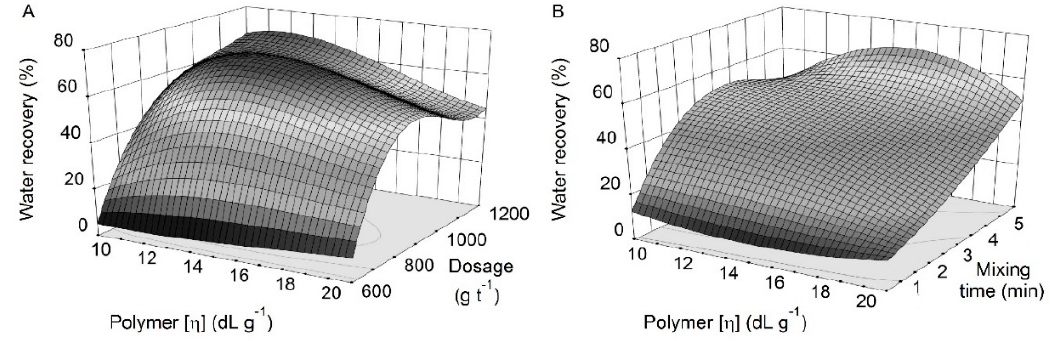
Figure 12. Polyacrylamide (PAM) water recoveries as a function of ( A ) dosage at a mixing time of 5 min, and ( B ) mixing time at a dosage of 800 g t − 1 . [Ca 2 + ] 0.005 M, 20 wt % kaolin suspensions.